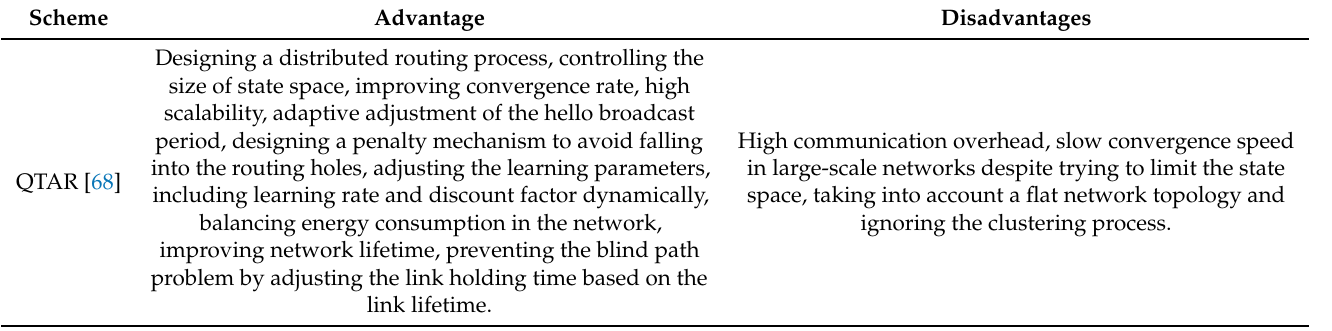
Figure 27. Learning process in QTAR. Table 9. The most important advantages and disadvantages of